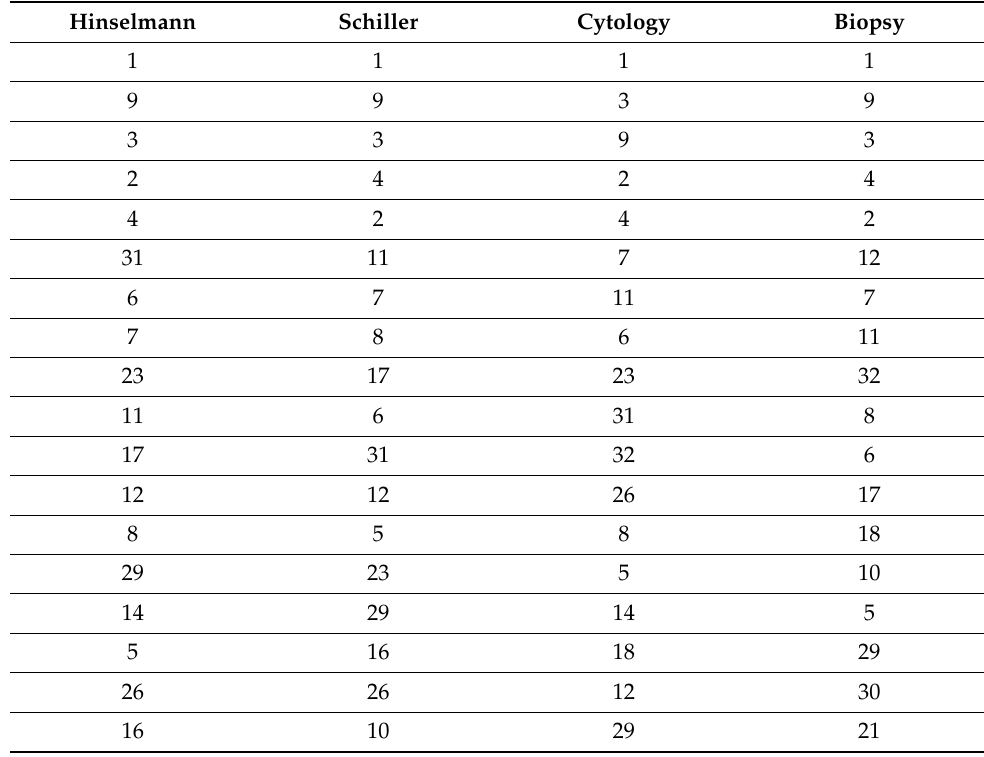
Table 2. Top 18 factors for four target variables based on RF relative importance sequence.